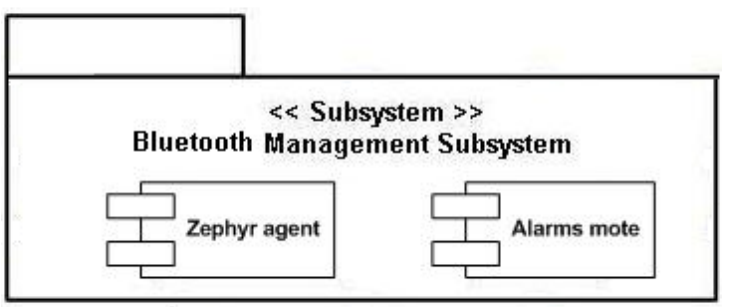
Figure 18. Bluetooth Management subsystem and its inner